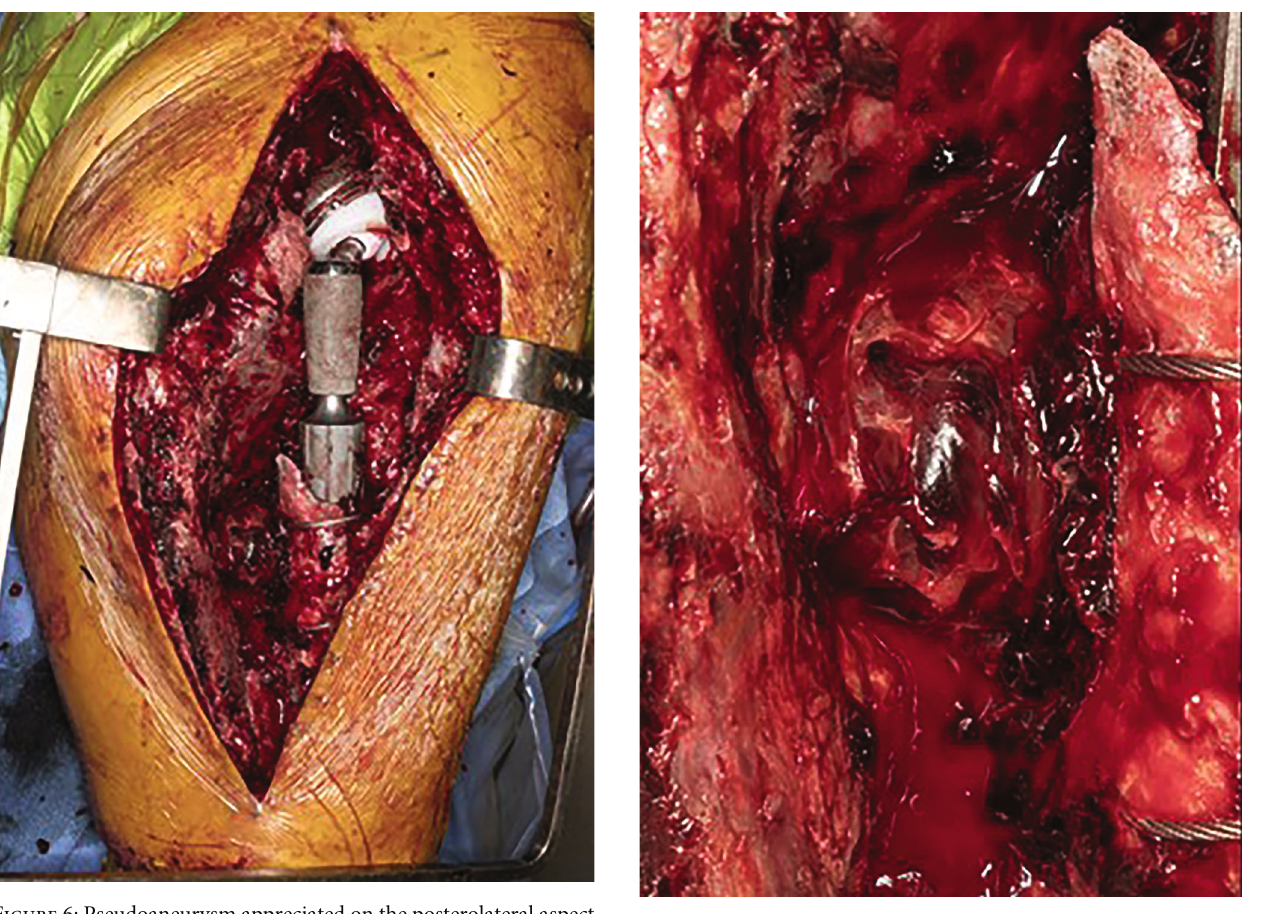
Figure 7: A close-up image of the pseudoaneurysm from Figure